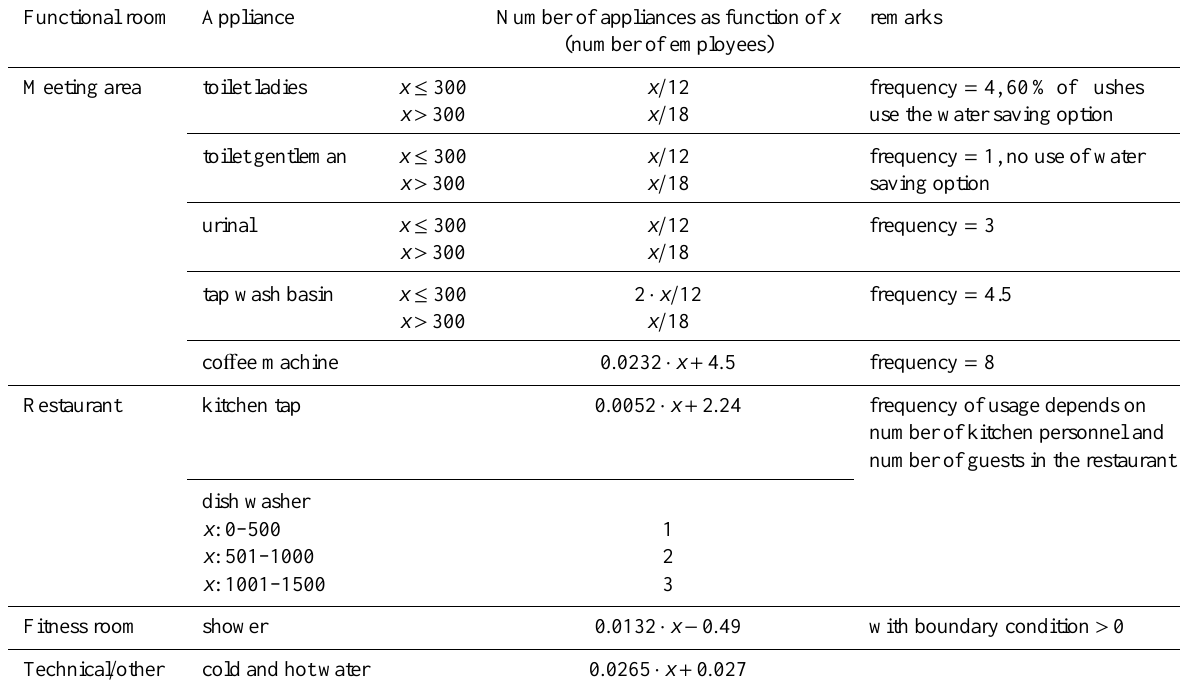
Table 5. Number of appliances in each functional room of a standardised o ffi ce as function of the dominant variable, x the number of